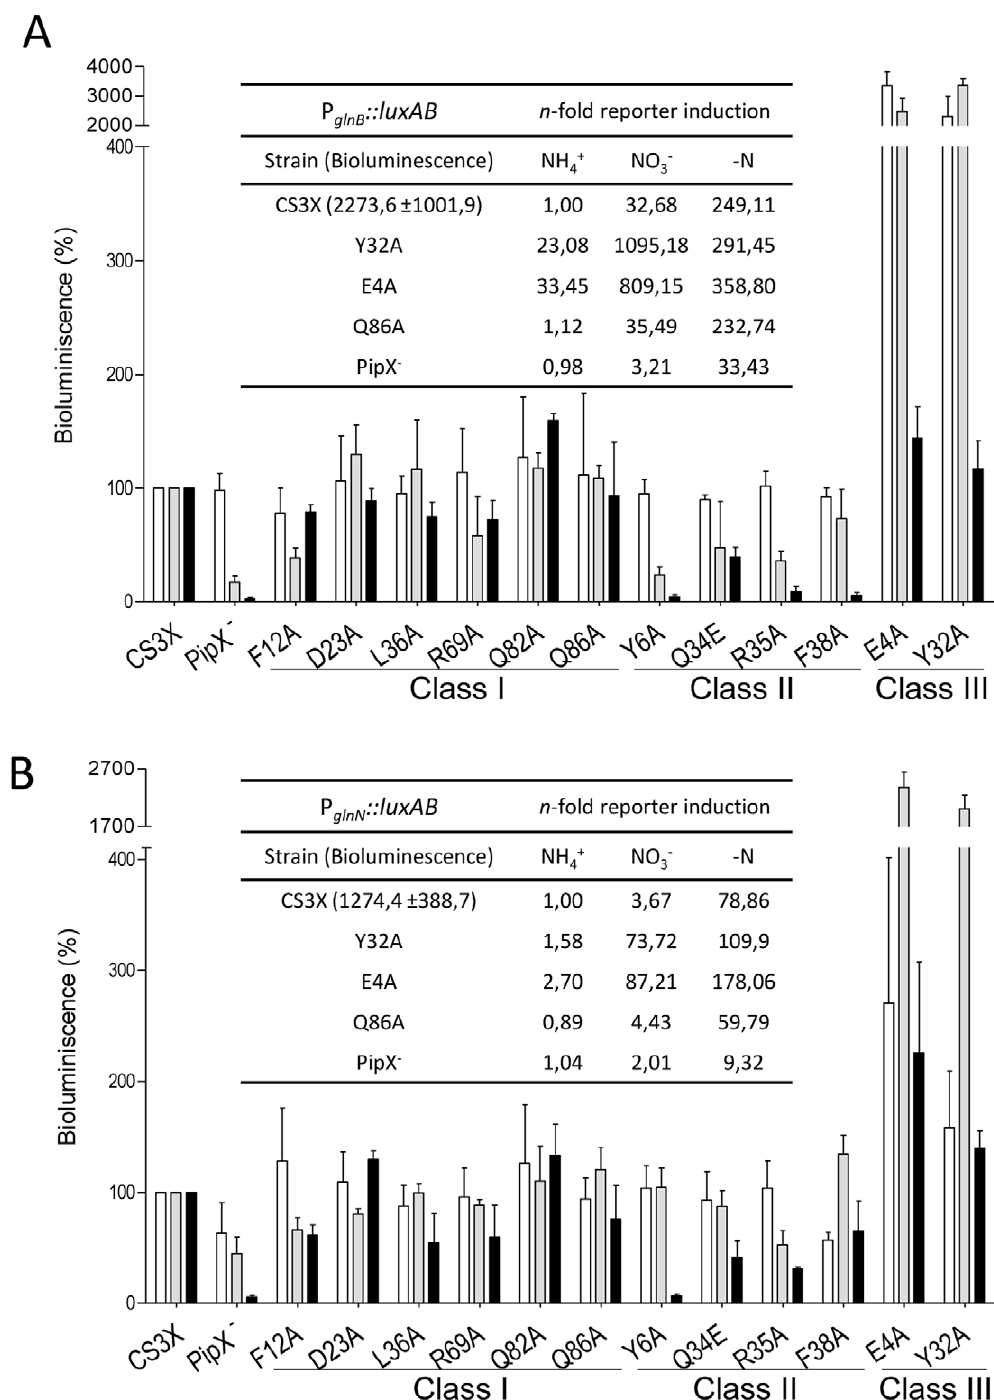
Figure 4. Effect of pipX mutations on P glnB :: luxAB (A) and P glnN :: luxAB (B) expression. Bioluminescence relative to the levels in the control strain (CS3X) were determined in cells grown in the presence of ammonium (white bars), nitrate (grey bars) and 24 h after cultures were shifted from ammonium-containing to nitrogen-depleted medium (black bars). Means 6 SD values from at least 3 independent experiments are plotted. pipX mutant (PipX - ), control strain (CS3X) and point mutants (derived from CS3X) are indicated. The inset shows the absolute bioluminescence values for CS3X grown in ammonium and the induction of these values under different nitrogen regimens and/or selected genetic backgrounds.